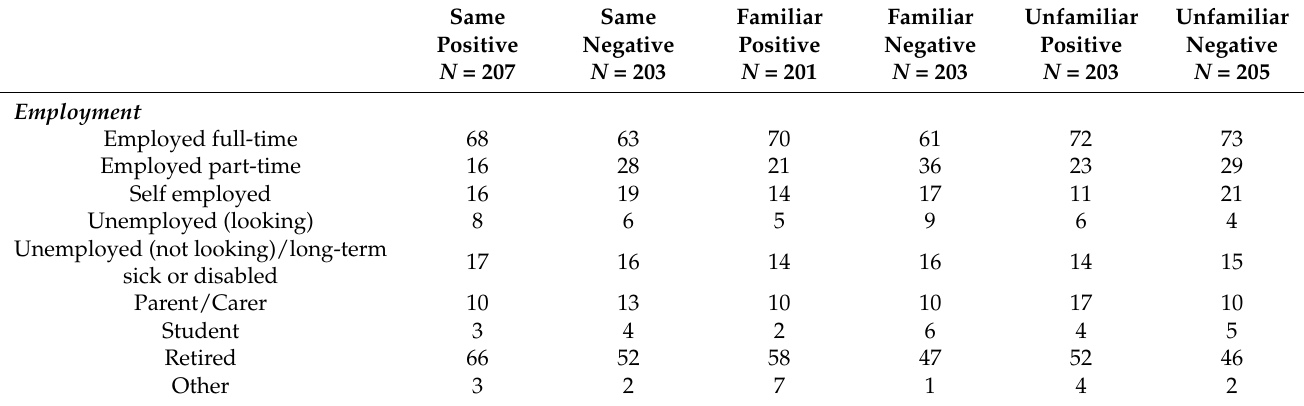
Table 1. Descriptive statistics (frequency counts) regarding demographics information for each experimental